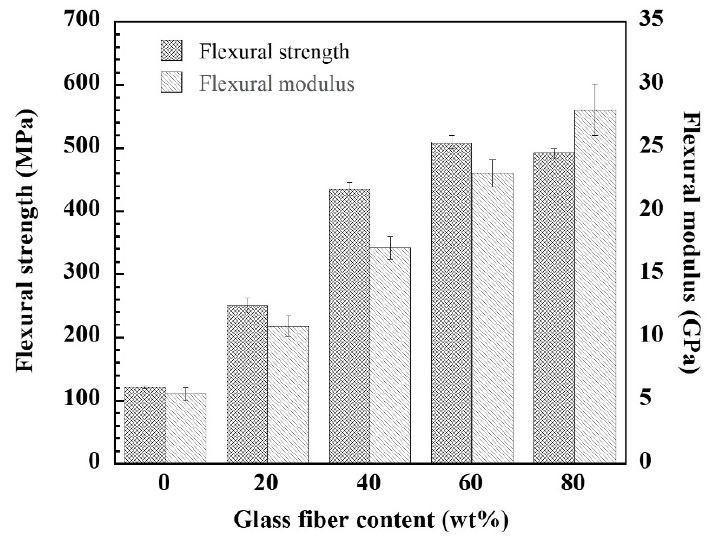
Figure 3. Flexural property of GF-reinforced poly(BA-a) composites at various GF